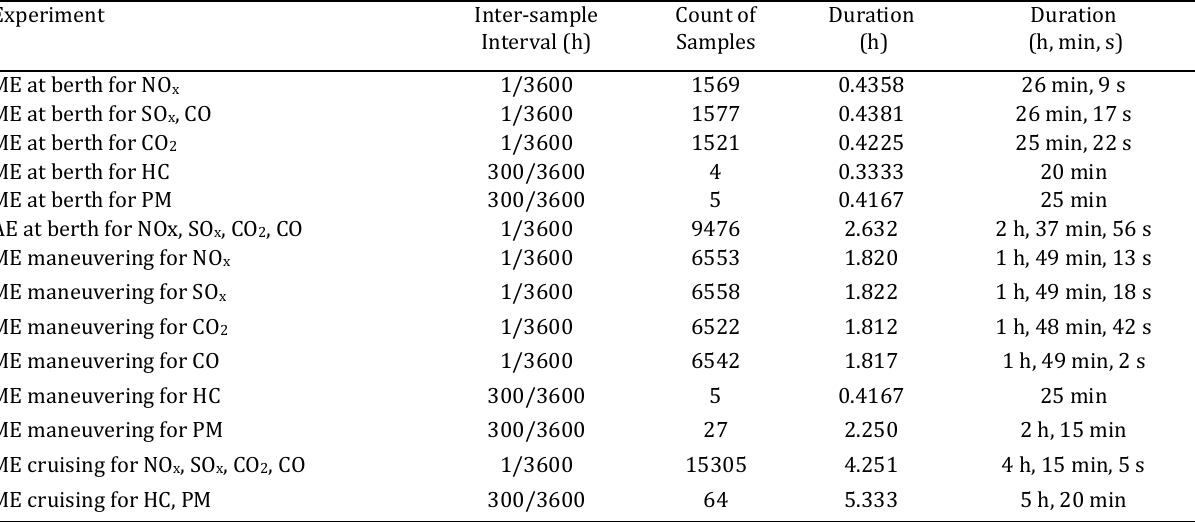
Table 1: Measurement process parameters